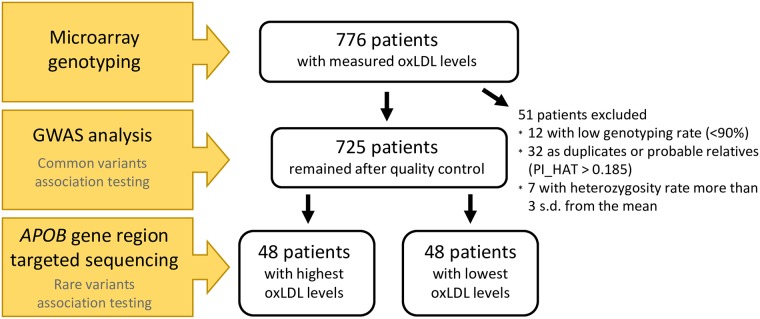
Cohort diagram indicating a number of patients participating into different steps of research.